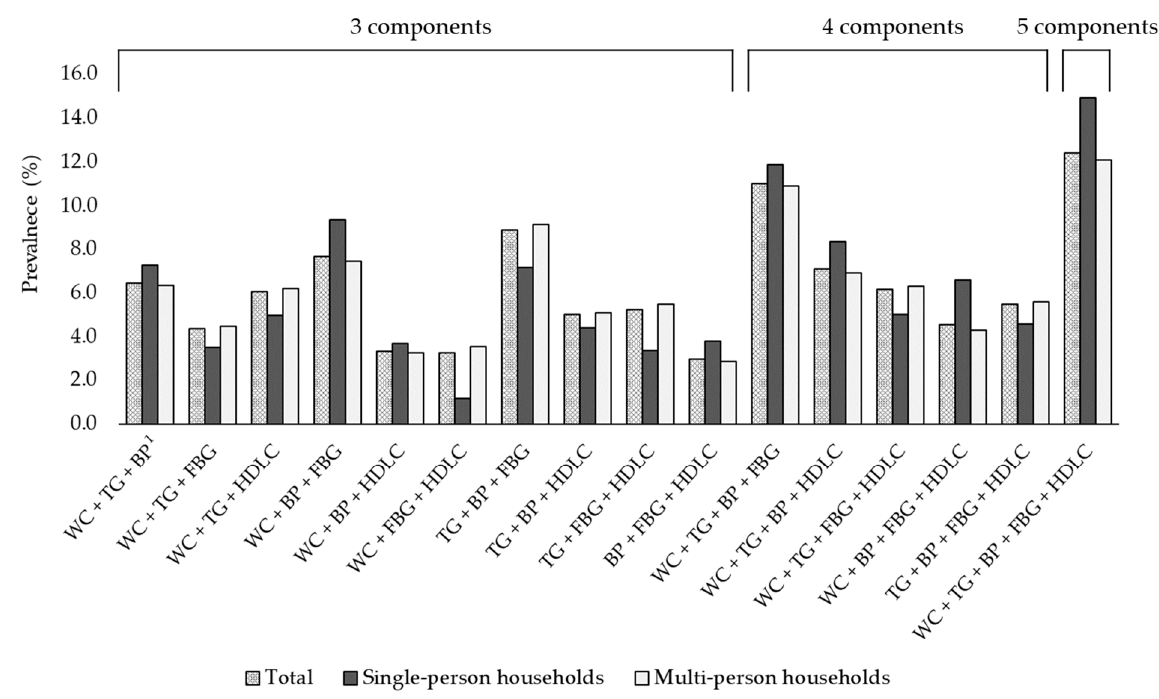
Figure 4. Prevalence of each metabolic syndrome component combination among Korean adults according to household type, KNHANES 2014–2018. KNHANES, Korea National Health and Nutrition Examination Survey; WC, waist circumference; TG, triglycerides; BP, blood pressure; FBG, fasting blood glucose; HDL-C, high-density lipoprotein cholesterol. 1 Each component of MetS was defined as follows: (1) excessive WC (WC ≥ 90 cm in men and ≥ 85 cm in women); (2) elevated TG (fasting TG ≥ 150 mg/dL or receiving treatment for hypertriglyceridemia); (3) elevated BP (systolic BP ≥ 130 mmHg or diastolic BP ≥ 85 mmHg or receiving treatment for or previously diagnosed with hypertension); (4) elevated FBG (FBG ≥ 100 mg/dL or receiving treatment for or previously diagnosed with type 2 diabetes mellitus); and (5) low HDL-C (fasting HDL-C < 40 mg/dL in men and < 50 mg/dL in women).